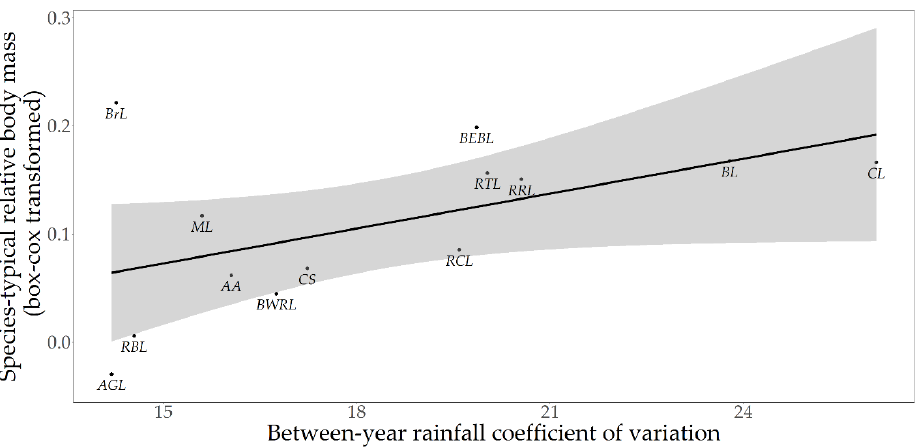
Figure 4. Relationship between between-year rainfall coe ffi cient of variation and species-typical median relative body mass across 13 lemur species ( t 11 = 2.04, R 2 = 0.27, λ < 0.001, p = 0.07). The shaded area shows the 95% confidence region. Labels : AGL: Alaotran gentle lemur; AA: aye aye; BEBL: blue-eyed black lemur; BL: black lemur; BrL: brown lemur; BWRL: black-and-white ru ff ed lemur; CL: crowned lemur; RCL: red-collared lemur; RCL: Coquerel’s sifaka; ML: mongoose lemur; RBL: red-bellied lemur; RRL: red ru ff ed lemur; RTL: ring-tailed lemur. Table 4. Results of hypothesis-testing model results performed over a tree block of 1000 alternative Lemuriform phylogenetic trees. Because values for upper and lower 95% confidence intervals were identical to medians in all cases, here we provide median values for each parameter. CV = coefficient of variation. Results were considered significant at p < 0.05, and trends ( p < 0.10) are italicised. All p values are two-tailed.